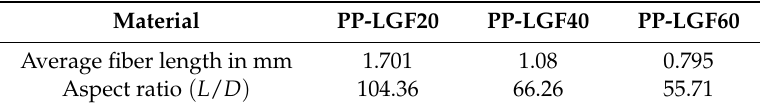
Table 1. Experimentally determined number average fiber length at the sprue.